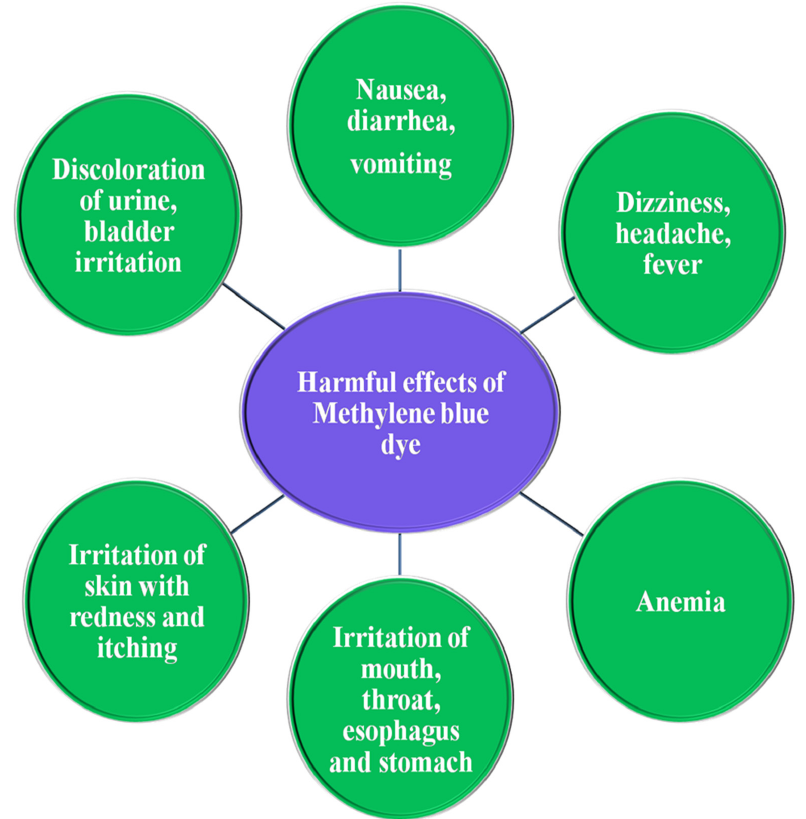
Figure 5. Harmful effects of the MB dye.